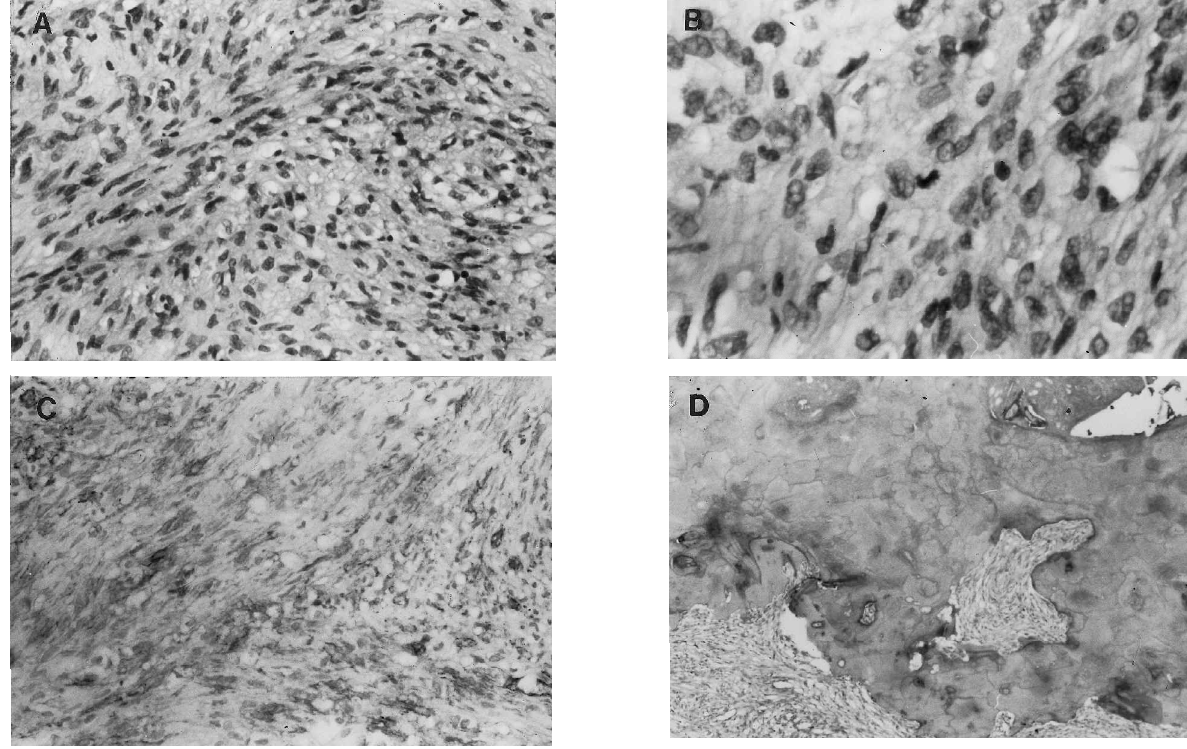
Fig. 3. Photomicrograph of the tumour in the proximal femur showing the morphological features of the tumour under (a) low-power and (b) high-power. The tumour has a fascicular pattern and is composed of spindle-shaped cells showing brisk mitotic activity. In keeping with the diagnosis of leiomyosarcoma, the tumour cells express smooth muscle actin (c). The tumour arose in association with a sclerotic medullary bone infarct (d). (a,b,d) Haematoxylin and eosin, original magnification, × 200, × 400, × 600, respectively; (c) immunoperoxidase, original magnification, ×